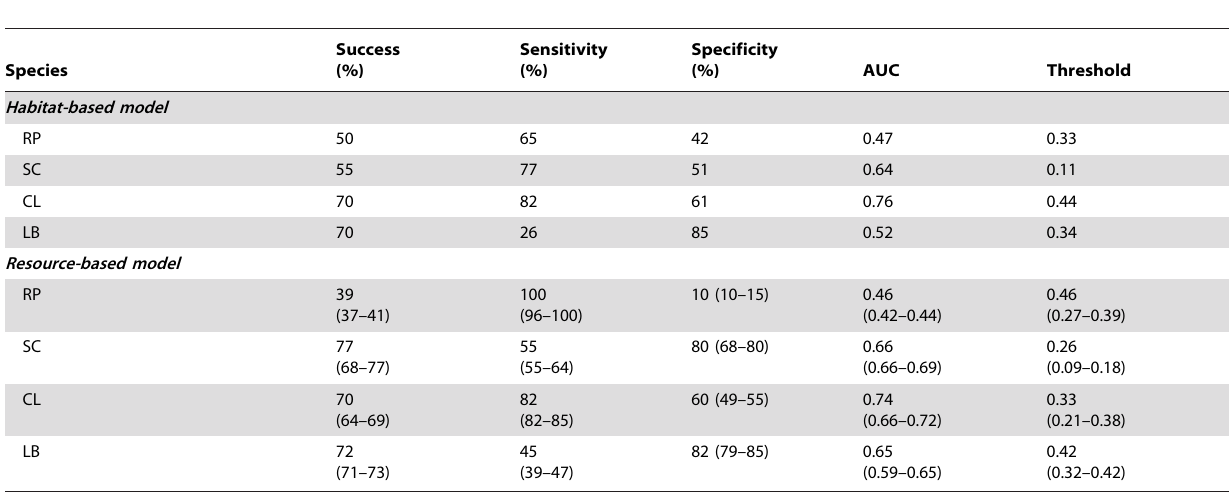
Table 3. Model performance of habitat-based and resource-based models for predicting the occurrence of four steppe bird species in the study